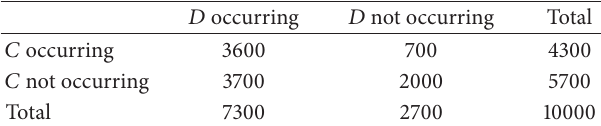
Table 4: The occurrence of “ 𝐶 ” and “ 𝐷